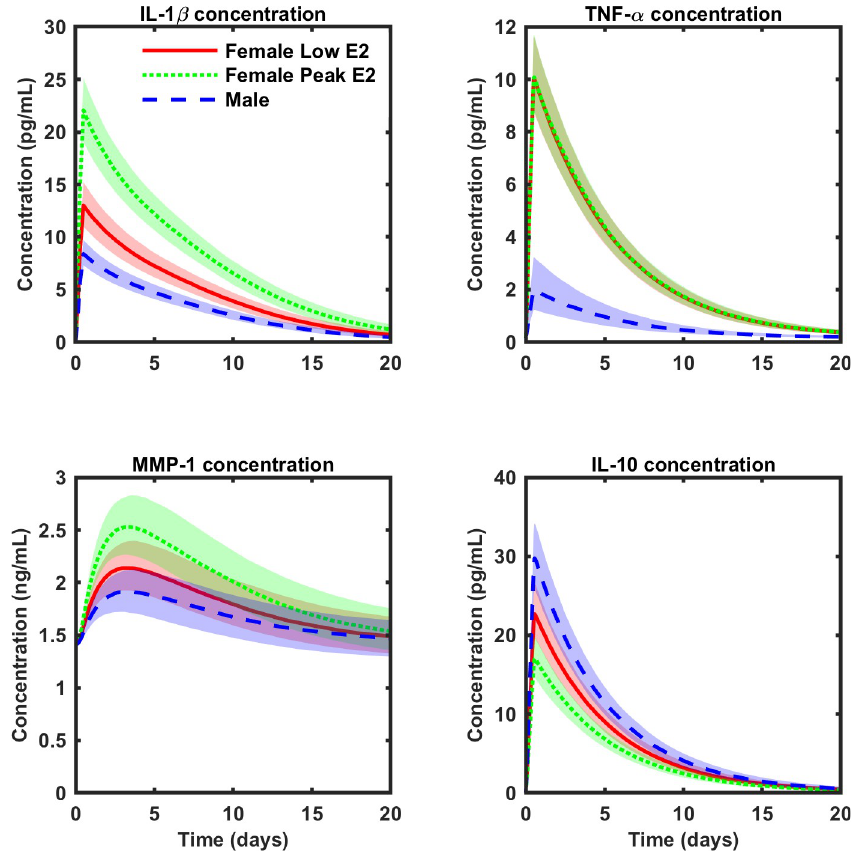
Fig 5. Effects of combined estrogen and testosterone at physiological levels for males and females (median ± IQR). Blue: combined T and E at concentrations for adult males; red solid: females with combined T and E at concentrations for females in the early follicular phase (Female Low E); green dotted: combined T and E for females with a steady estrogen concentration that varies around the peak value of estrogen during the menstrual cycle (Female Peak E). Kruskal-Wallis testing and post hoc Mann-Whitney U testing (with the Bonferroni correction) reveal highly significant differences between hormonal conditions at nearly all time points for all substances (analysis included in S1 Scripts). For IL-1 β , IL-10, and MMP-1, there are significant differences between every possible hormone pair: “Male” is significantly different from “Female Peak E;” “Male” is significantly different from “Female Low E;” and “Female Peak E” is significantly different from “Female Low E.” The difference in MMP-1 concentration between “Male” and “Female Low E” lose significance at t = 19 days and t = 20 days. TNF- α is the only exception, as it shows no significant differences between “Female Low E” and “Female Peak E” at any time point. Further, no differences exist between hormone conditions t = 0 days, since the initial conditions are the same, regardless of the hormone treatment.